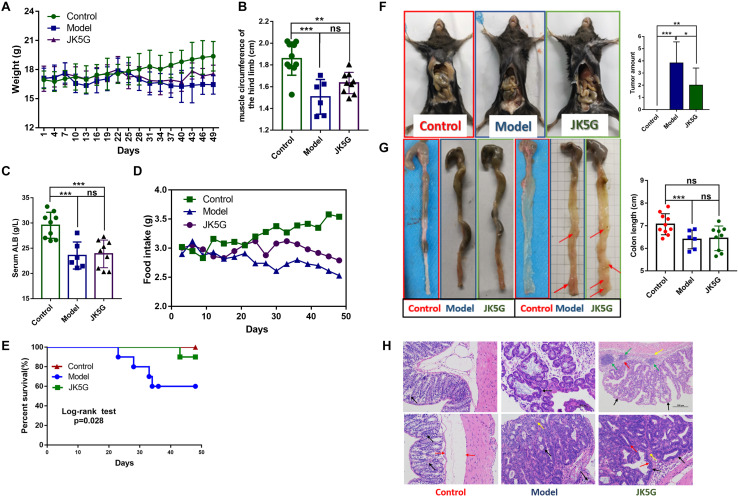
Mouse weights, general nutritional status, food intake, and survival rate and growth of colorectal cancer over time. When compared with the model group, the weight (A), food intake (D), and survival rate (E) of the microecological preparation group were significant (p < 0.05). The muscle circumference (B) and serum albumin (C) of the hindlimb of the microecological preparation group were higher than those of the model group, but the difference was not significant (p > 0.05). Compared with the model groups, the tumor size (F) and number (G) were lower in the microecological preparation group (p < 0.05). Hematoxylin and eosin staining of colon tissues showed that the tissue in the model group exhibited an obvious boundary between the tumor and surrounding tissues, with inflammatory cells infiltrating into the submucosa (H). *p < 0.05; **p < 0.01; ***p < 0.001.